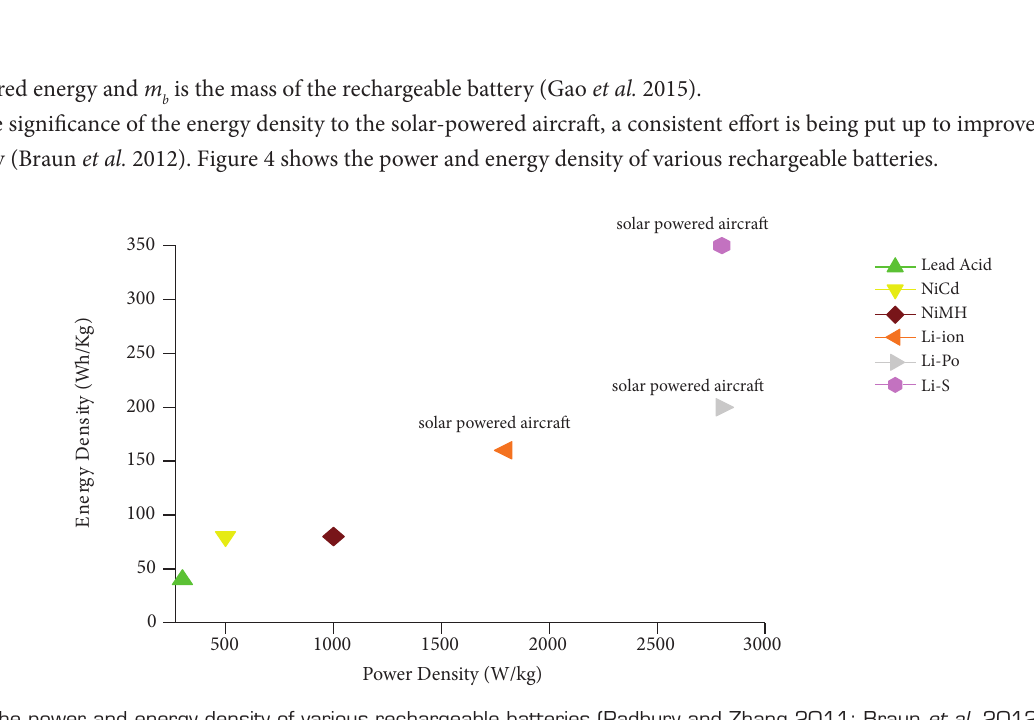
Figure 4. The power and energy density of various rechargeable batteries (Padbury and Zhang 2011; Braun et al. 2012). A limitation of aircraft powered by solar energy is the low energy densities of the power propulsion. For this reason, high- energy density storage device is inevitable (Sliwinski et al. 2017). There are different energy storage devices, but their choice is determined by their area of application (Wagner